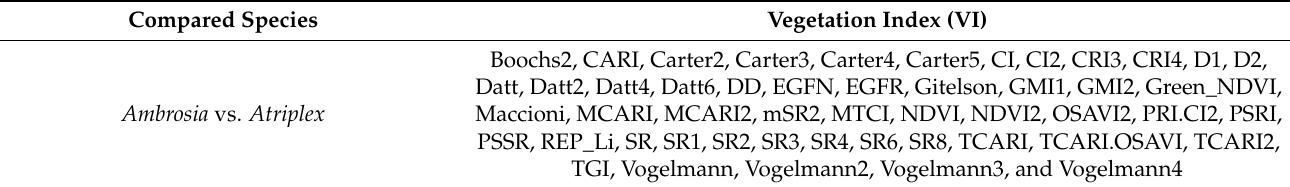
Table 4. VIs suitable to distinguish species.